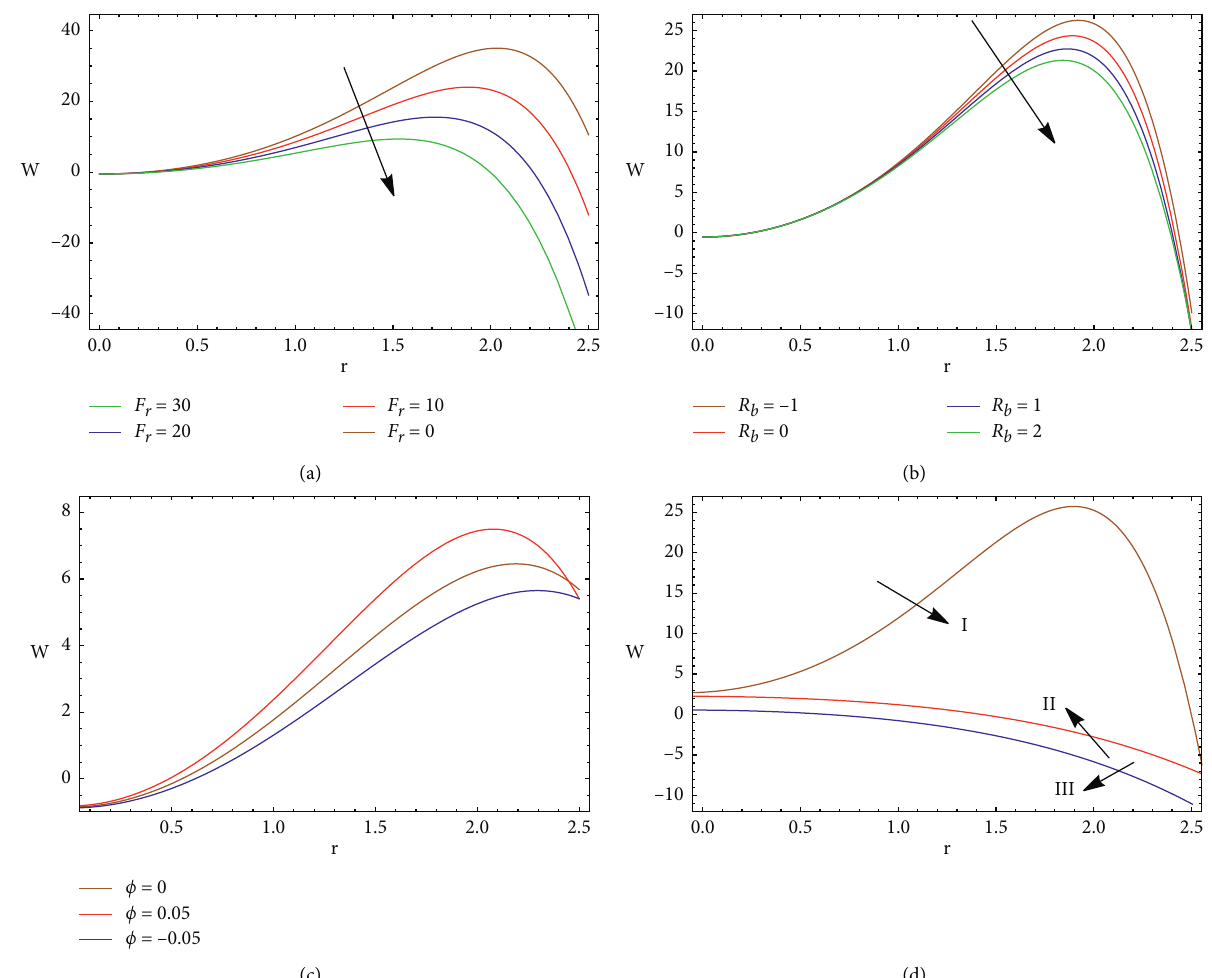
Figure 3: The variation of the axial velocity w ( r ) for different values of F